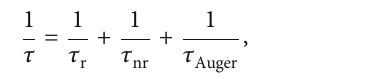
Table 2: Parameters in the minority carrier di ff usion equations (Equation